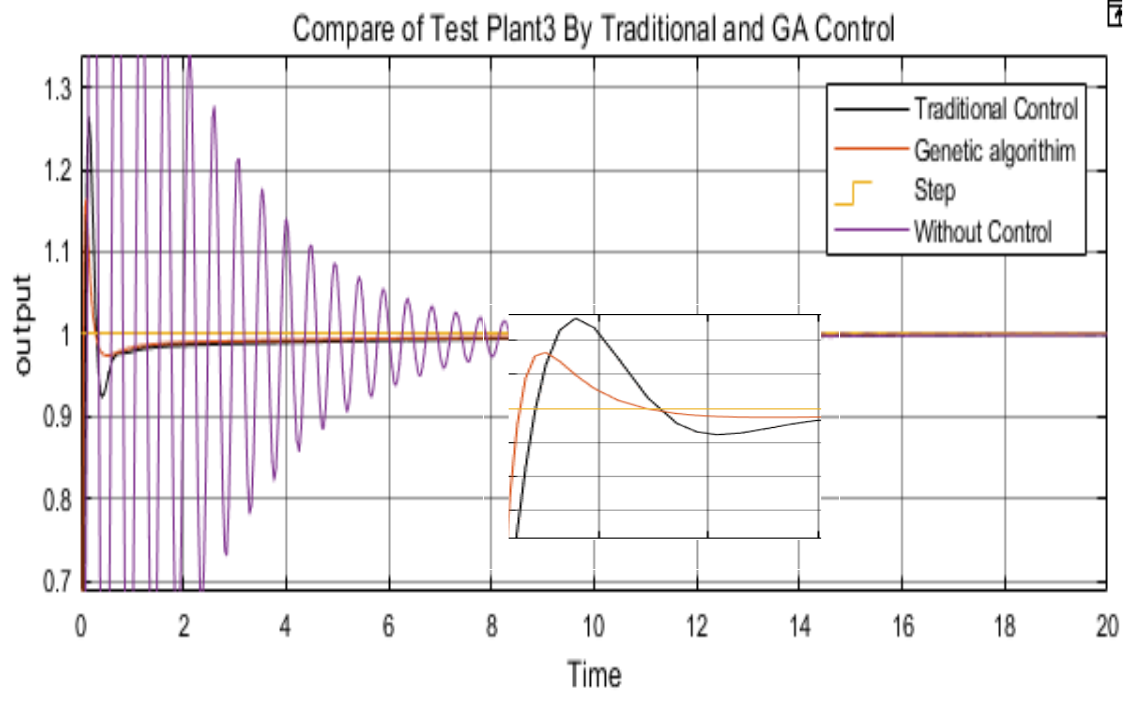
Fig. 10. Comparisons between traditional-PID method and